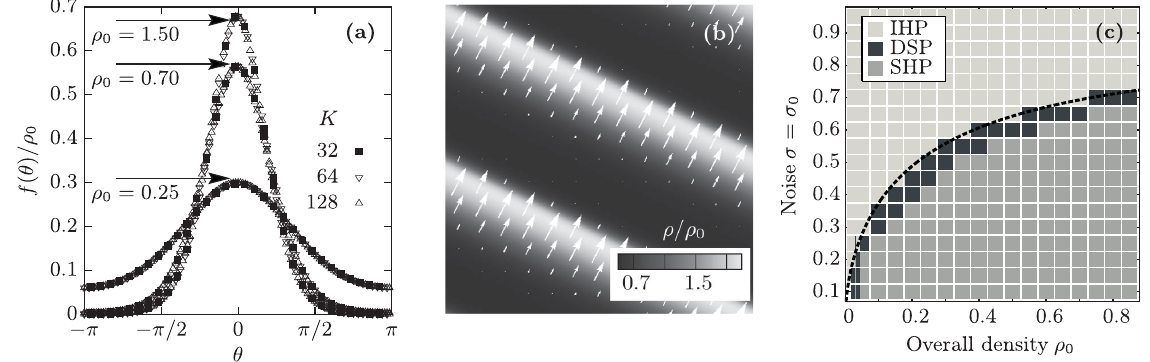
FIG. 2. (a) Stationary solution for the one-particle distribution function f ð θ Þ according to Eq. (21) for a spatially homogeneous system with L ¼ 1 , σ ¼ σ 0 ¼ 0 . 5 , and K ¼ 32 , 64, and 128 angular slices for various overall densities ρ 0 (indicated in the figure). (b) Representative snapshot of a stationary traveling-wave pattern for ρ 0 ¼ 0 . 25 and σ ¼ σ 0 ¼ 0 . 5 . The color code indicates local density; the length and direction of arrows indicate the magnitude and orientation of the local particle flow. (c) Phase diagram for different values of the overall density ρ 0 and noise amplitude σ ¼ σ 0 . The analytic result for the phase boundary [refer to Eq. (34)] is indicated by the dashed line. A DSP is observed all along the phase boundary between the IHP and the SHP. The system size L ¼ 100 , ϵ 5 , and K ¼ 32 for (b) and x ¼